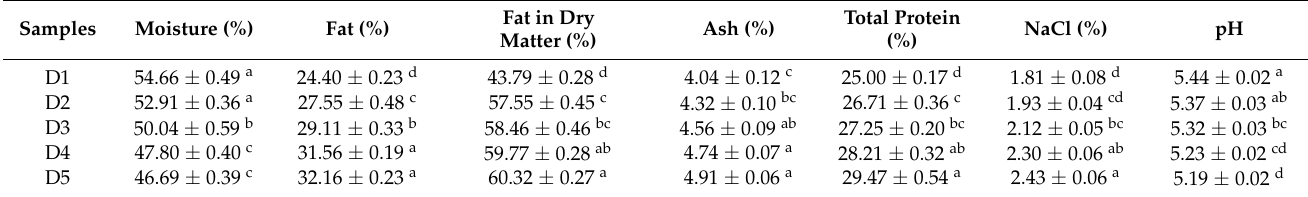
Table 1. Physico-chemical properties of cheese samples during ripening.